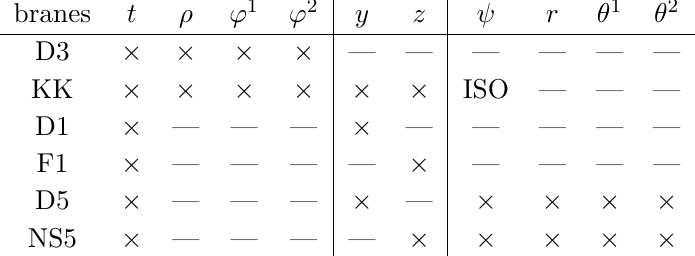
where s = sin α , c = cos α and the orbifolded 3-sphere is written